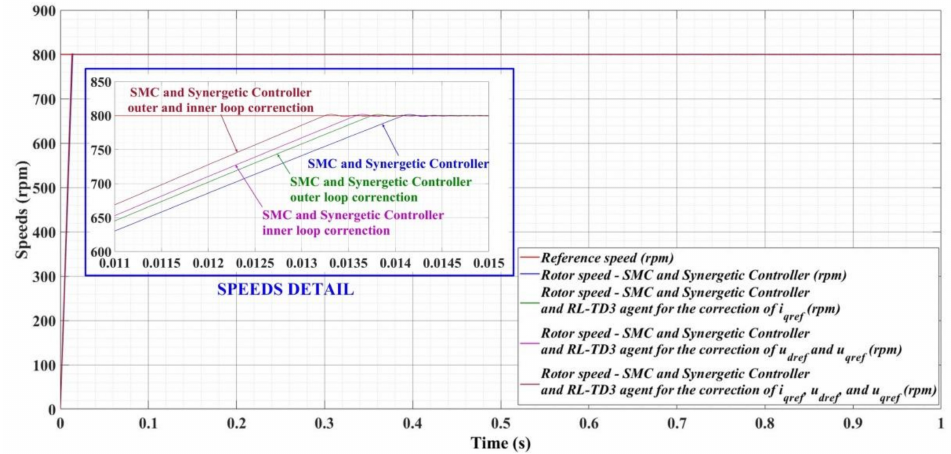
Figure 40. Comparison of the speed time evolution for the numerical simulation of the PMSM control system based on SMC and synergetic controllers using an RL-TD3 agent for the outer and inner loop